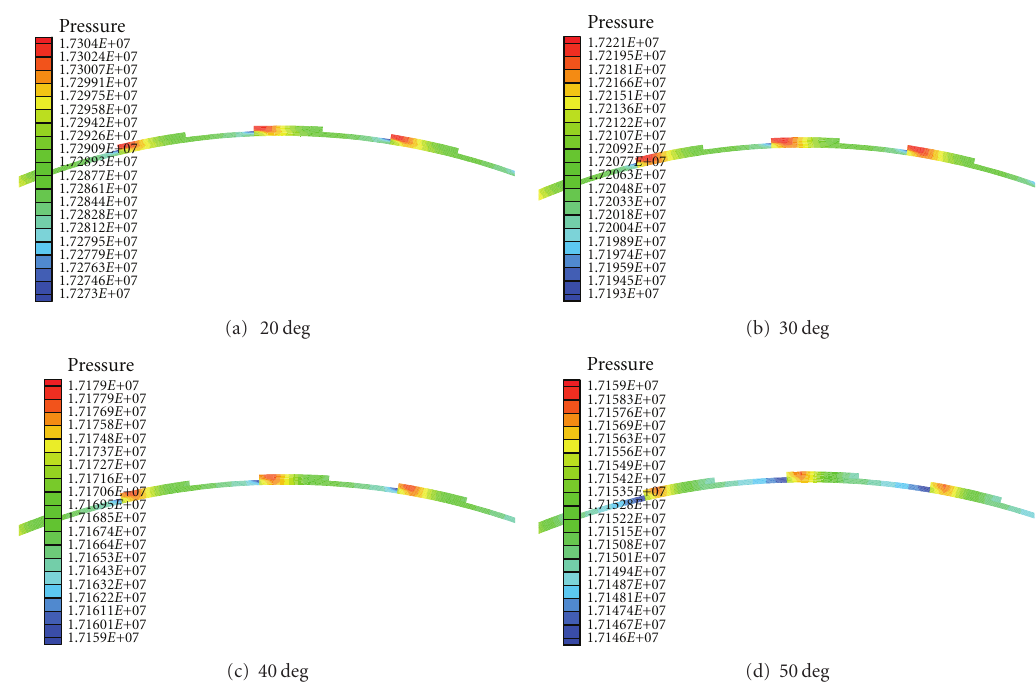
Figure 10: Pressure contour of 0.2 L cross section for four helix angles.